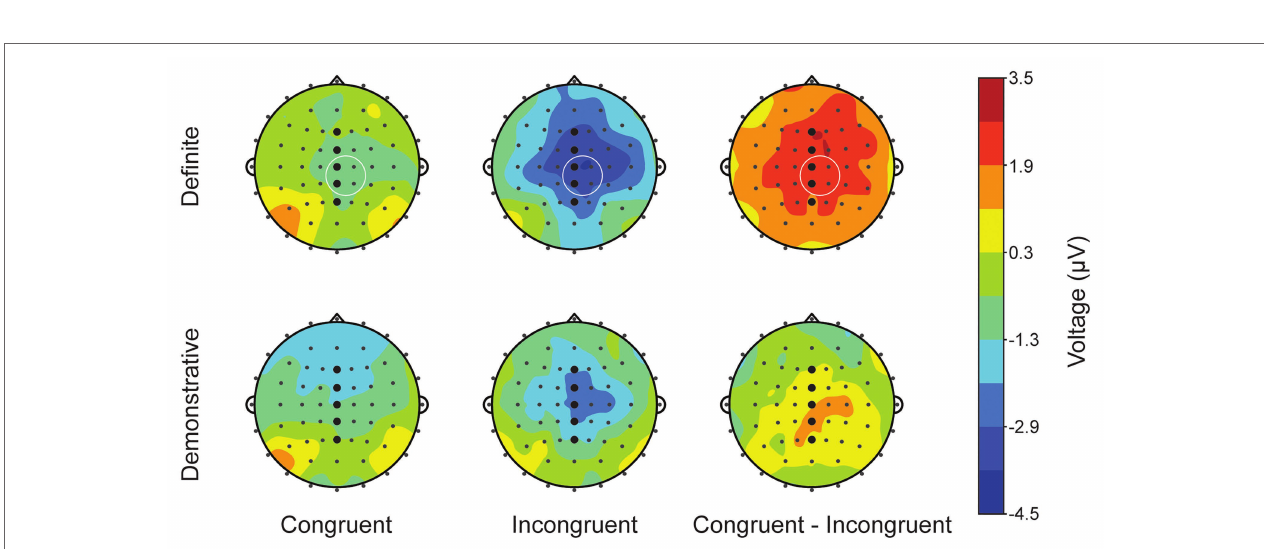
FIGURE 2 | Topographic plots of mean amplitude ( μ V) 300–500 ms after stimulus onset at CW for definite (top) and demonstrative (bottom) conditions. Black dots indicate scalp position of electrodes. Bolded black dots indicate midline electrode positions, used for ANOVA (see Section “N400 at the critical word”); white circles indicate the region of interest (ROI) used in correlational analyses (see Section “Correlational